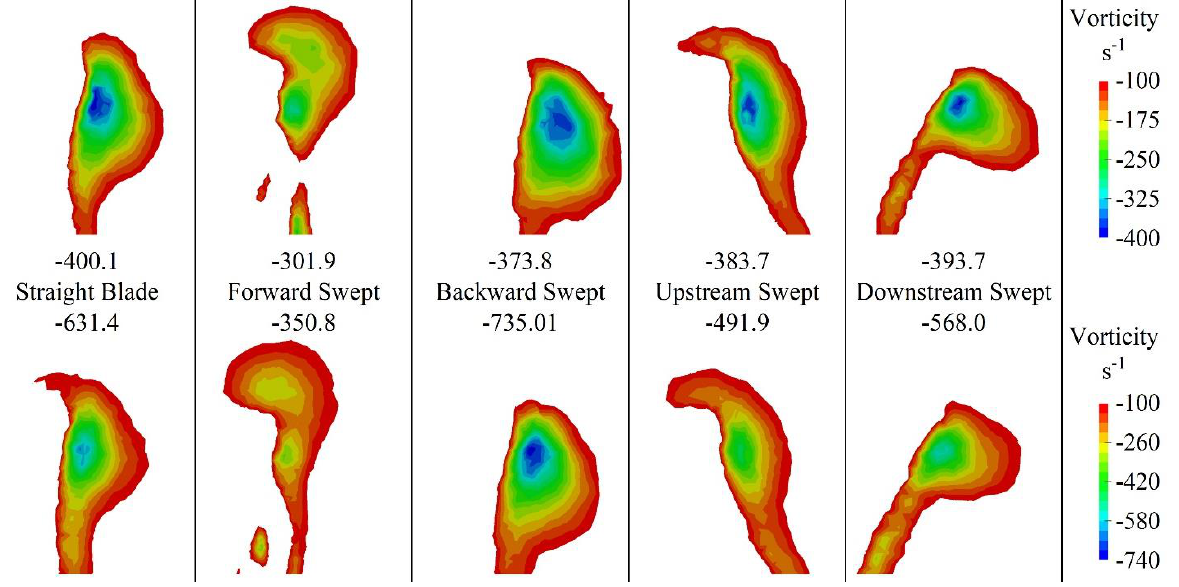
Figure 12. Tip vortices of different blades, the top for tip vortices at TSR = 6, and the bottom for tip vortices at TSR = 9; the digits in the middle denote the peak tip vorticity.